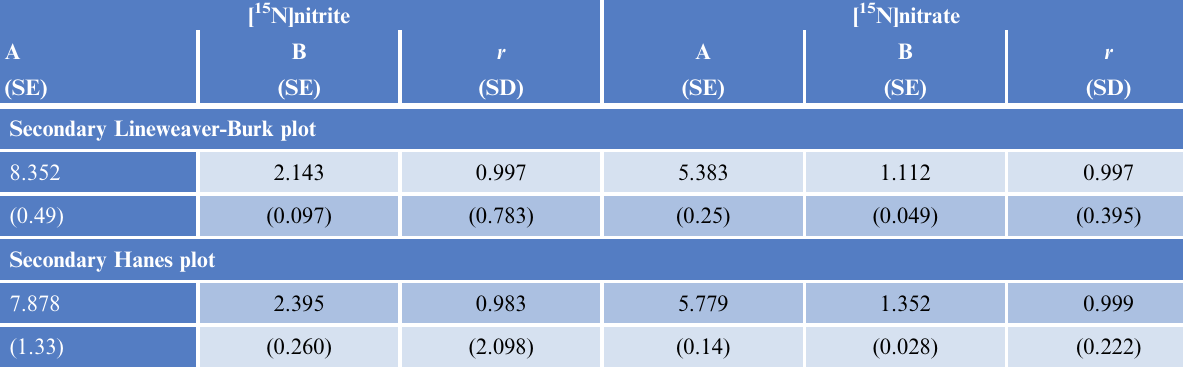
Table 2. Statistical data from secondary Lineweaver – Burk and Hanes